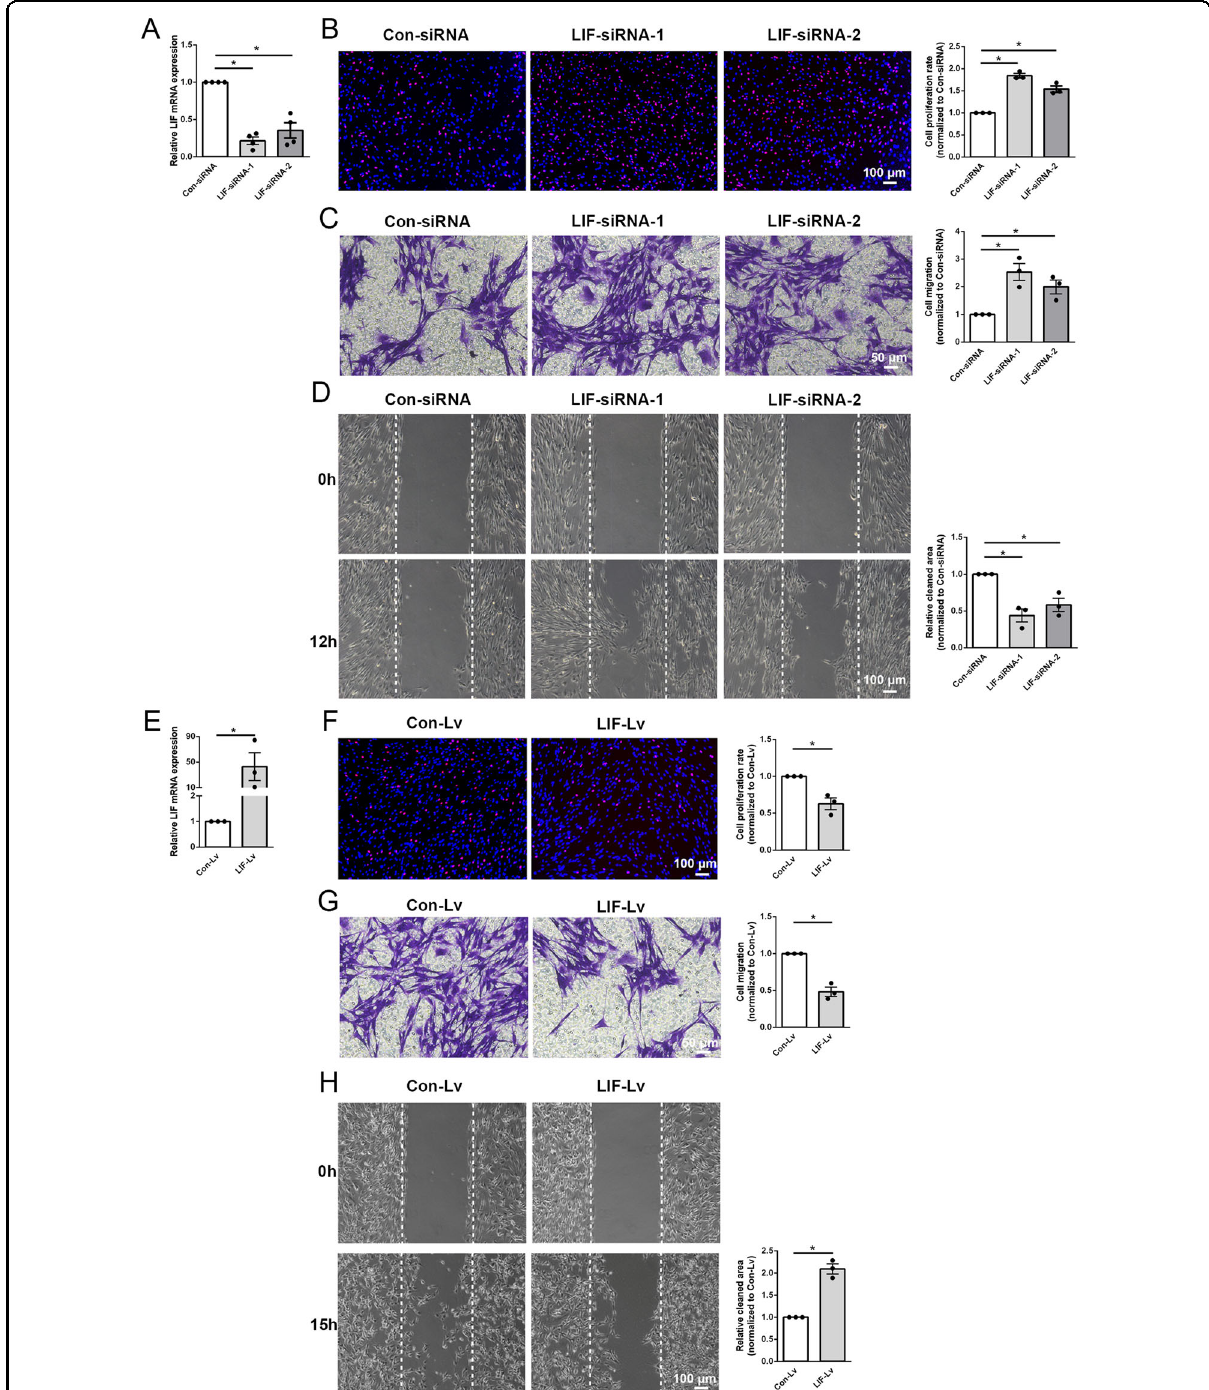
Fig. 1 LIF affects Schwann cell proliferation and migration. A Transfection of Schwann cells with LIF-siRNA-1 or LIF-siRNA-2 reduces the mRNA abundance of LIF. B LIF-siRNA-1 or LIF-siRNA-2 transfection increases Schwann cell proliferation. Red color indicates EdU-positive cells and blue color indicates nucleus. Scale bar indicates 100 μ m. C LIF-siRNA-1 or LIF-siRNA-2 transfection increases Schwann cell migration. Violet color indicates migrated cells. Scale bar indicates 50 μ m. D LIF-siRNA-1 or LIF-siRNA-2 transfection decreases cleaned areas between scratches. Scale bar indicates 100 μ m. E Transfection of Schwann cells with LIF-overexpressing lentivirus (LIF-Lv) reduces the mRNA abundance of LIF. F LIF-overexpressing lentivirus transfection decreases Schwann cell proliferation. Red color indicates EdU-positive cells and blue color indicated nucleus. Scale bar indicates 100 μ m. G LIF-overexpressing lentivirus transfection decreases Schwann cell migration. Violet color indicates migrated cells. Scale bar indicates 50 μ m. H LIF-overexpressing lentivirus transfection increases cleaned areas between scratches. Scale bar indicates 100 μ m. Data were presented as means ± SEM. * p value <0.05 versus control-siRNA (Con-siRNA) or control-lentivirus